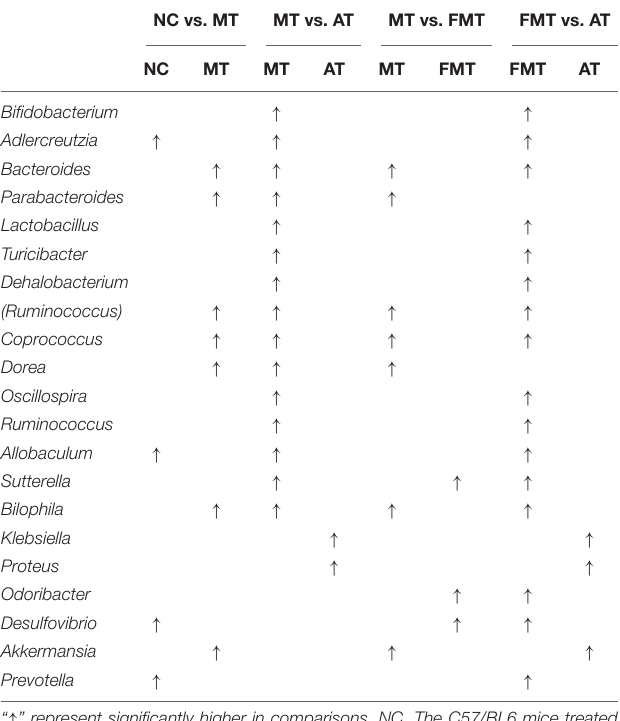
TABLE 1 | Significantly different genus among the four types of mice at 9 weeks